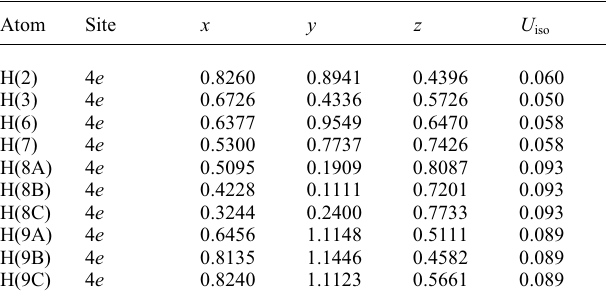
Table 2. Atomic coordinates and displacement parameters (in Å 2 )